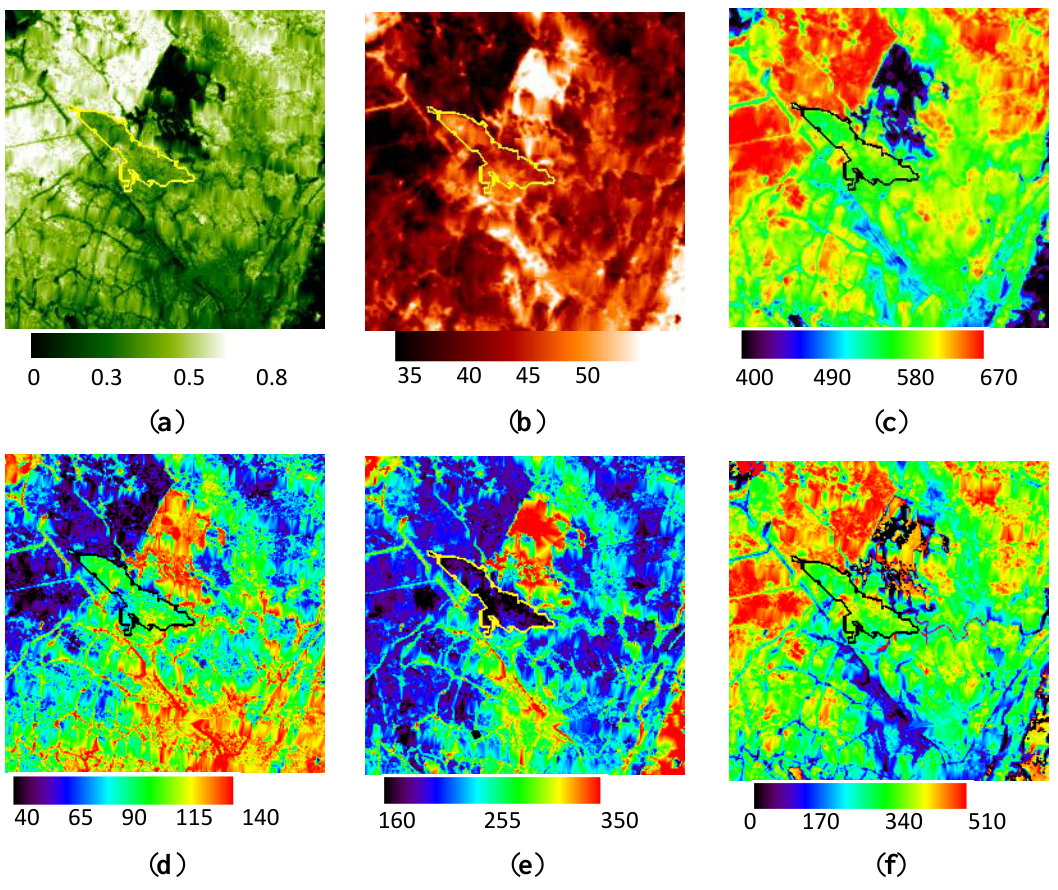
, ( b ) T (°C), ( c ) R (W·m −2 ), ( d ) G (W·m −2 ), v R n